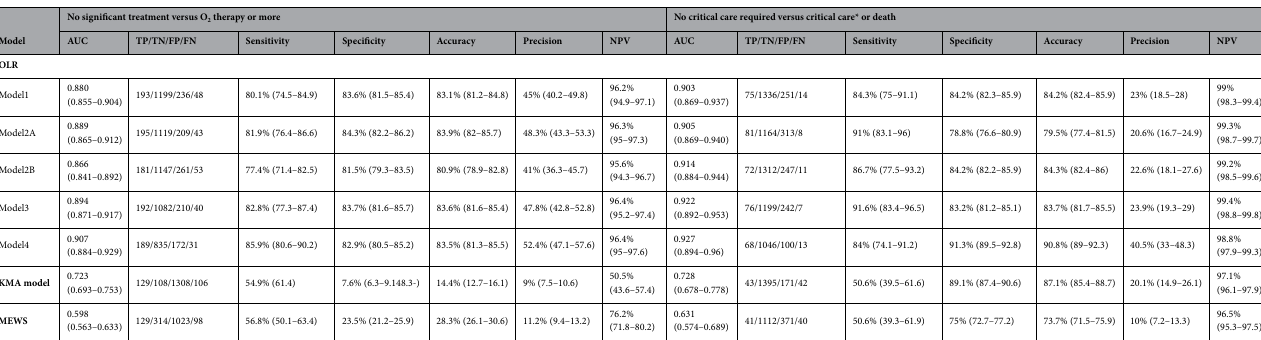
Table 2. Model performance in early prediction of prognosis in COVID19 patients in the internal validation cohort. The results of other machine learning algorithms can be found in Supplementary Table S5. Values in parentheses are 95% confidence intervals. OLR ordinal logistic regression, AUC area under the receiver operator characteristics curve, TP true positive, TN true negative, FP false positive, FN false negative, NPV negative predictive value, KMA Korean Medical Association, MEWS modified Early Warning Score. *The use of a ventilator or extracorporeal membrane oxygenation